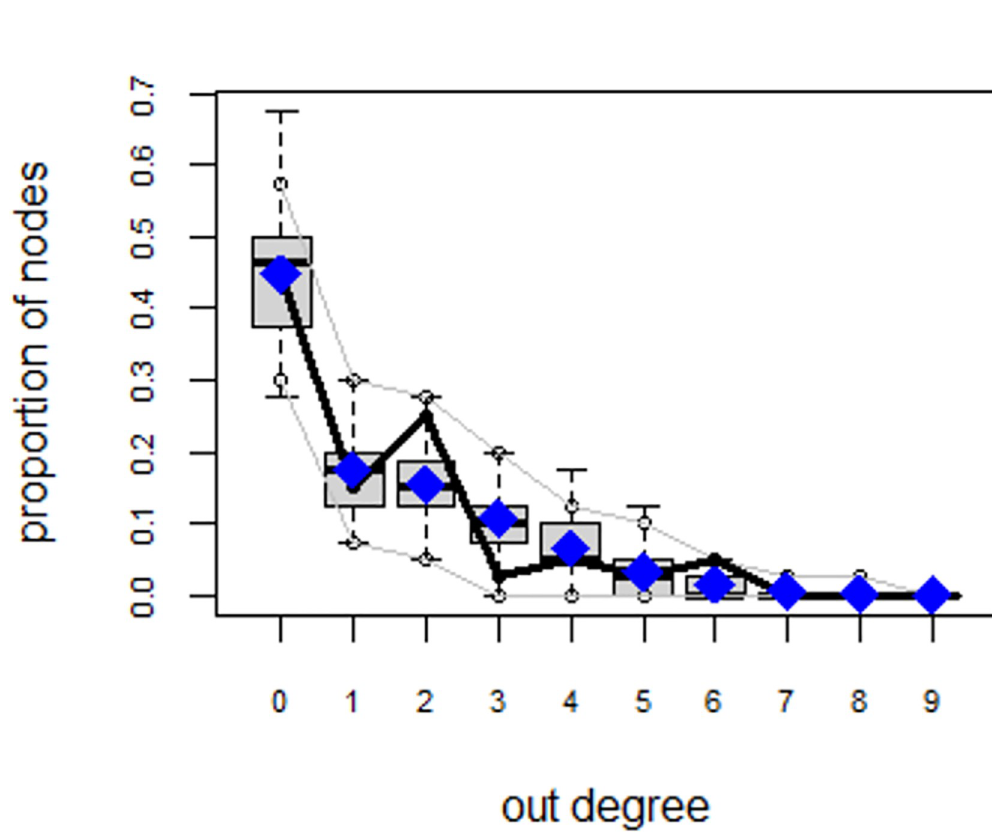
Fig 14. Multiplexity in the beta community—goodness of fit [24] out degree.